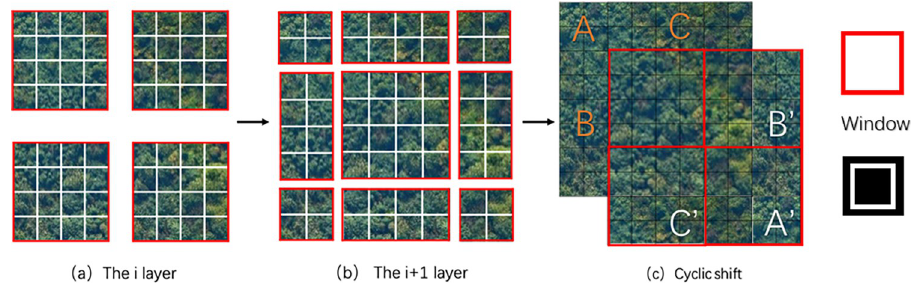
Fig 8. Window separation and